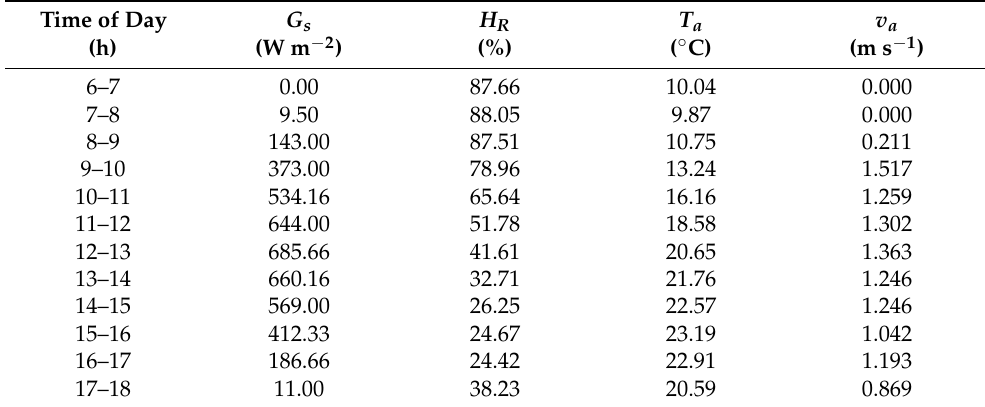
Table A4. Weather data set for the winter day (3 January 2020) used in the PVT-RO simulations.